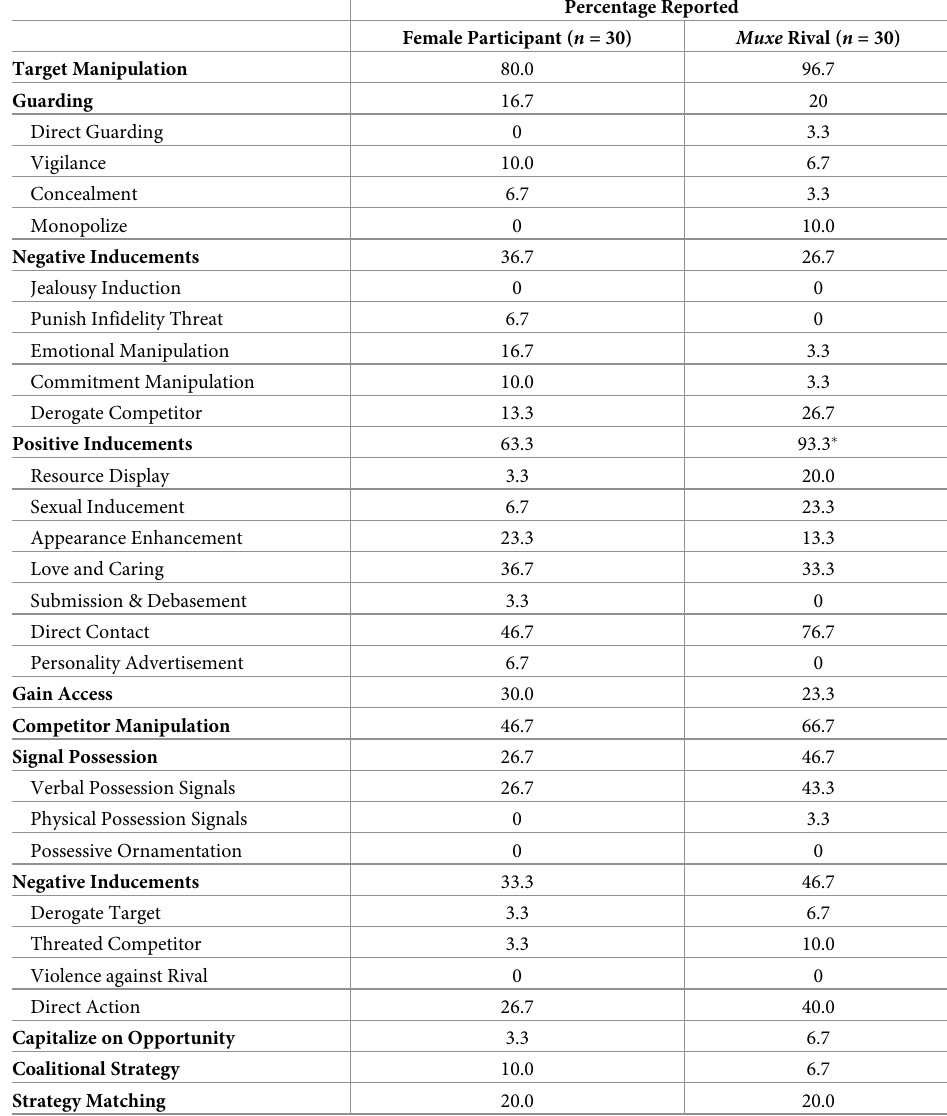
Table 3. Inter-sexual mate acquisition competition tactics in the Istmo